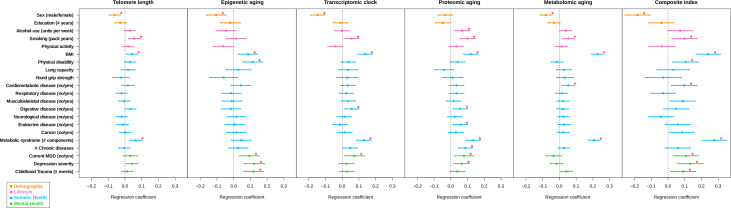
Forest plot of associations between biological aging and health determinants.For each of the associations between biological aging indicators and health determinants, the standardized beta and standard deviation derived from linear models were plotted. The significant associations (p<2e-2, FDR < 5%) are shown with red stars. The composite index, which is the scaled sum of the five biological aging indicators, clearly shows most associations and often largest effect sizes. Biological aging was used as outcome in the linear models. Beta for telomere length was multiplied by −1 to compare with other biological clocks. Red stars indicate FDR < 5%. All biological aging indicators were age-regressed, only telomere length was not.